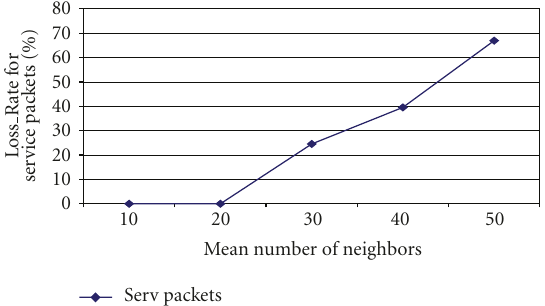
Figure 16: Service Packets-Loss Rate versus Mean Number of Neighbors (message generation rate = 150 msgs/s and mean message size = 500